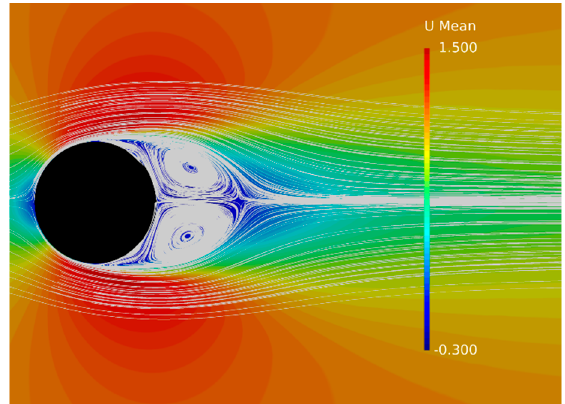
Figure 13. Streamlines of mean streamwise velocity, U = U / U ∞ .